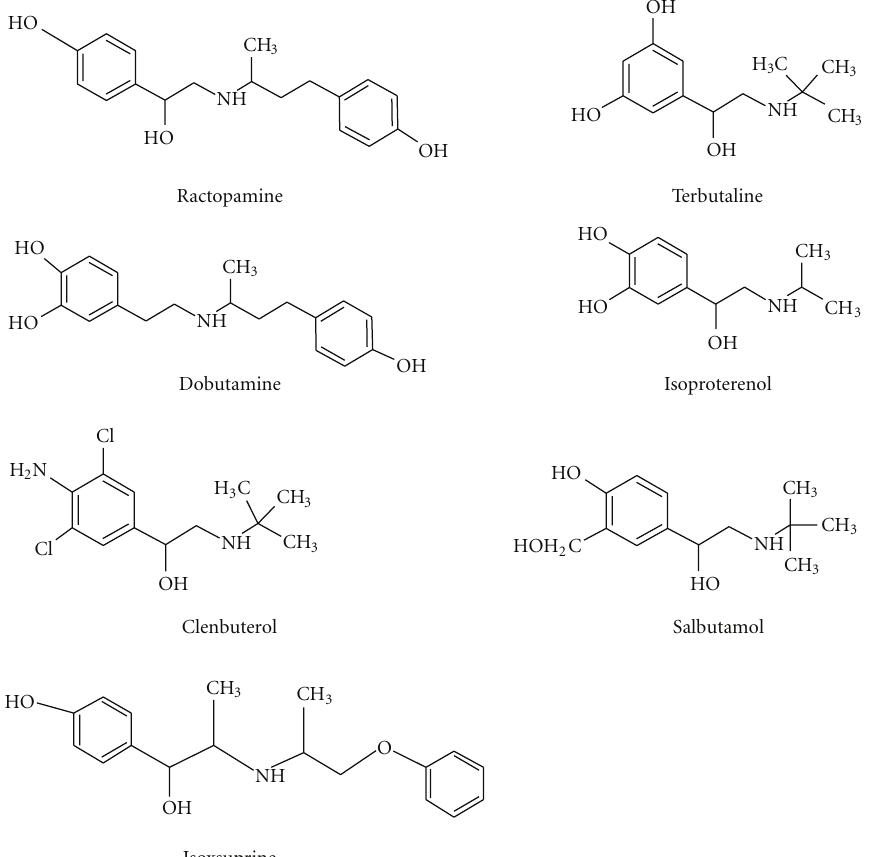
Figure 1: Structures of ractopamine and some closely related